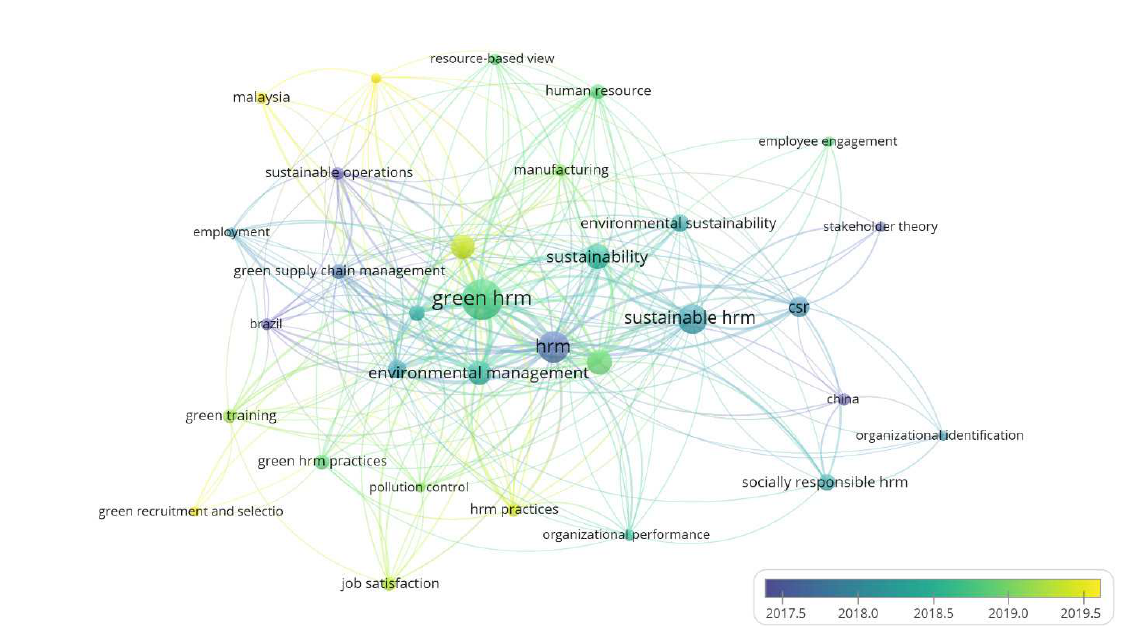
Figure 4. Temporal keyword co-occurrence analysis of sustainable HRM